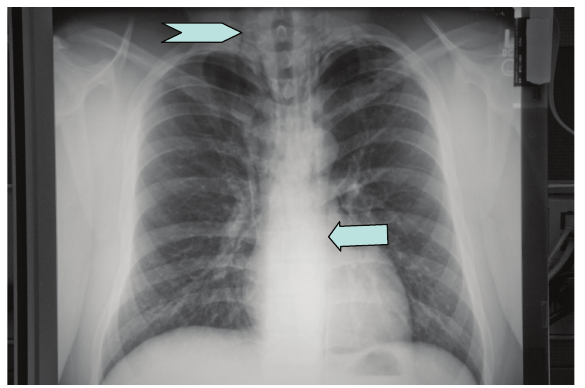
Figure 1: Initial chest X-ray showed subcutaneous emphysema, with air tracking into the neck area bilaterally (chevron), and a para- aortic air stripe of the left (arrow).